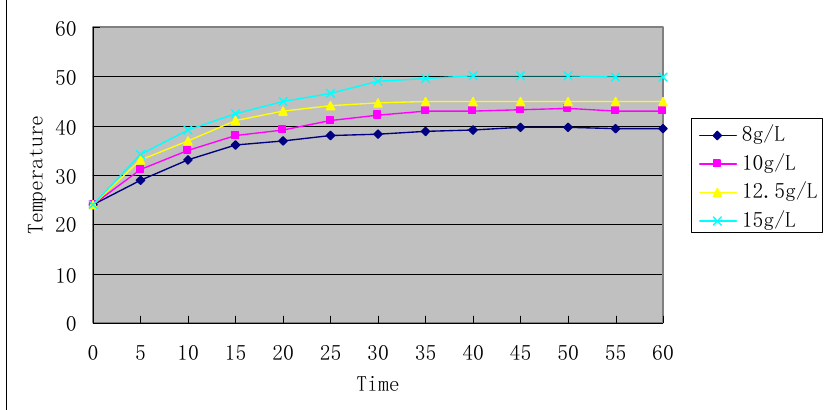
Zn Fe O nanoparticle 0.5 0.5 2 4